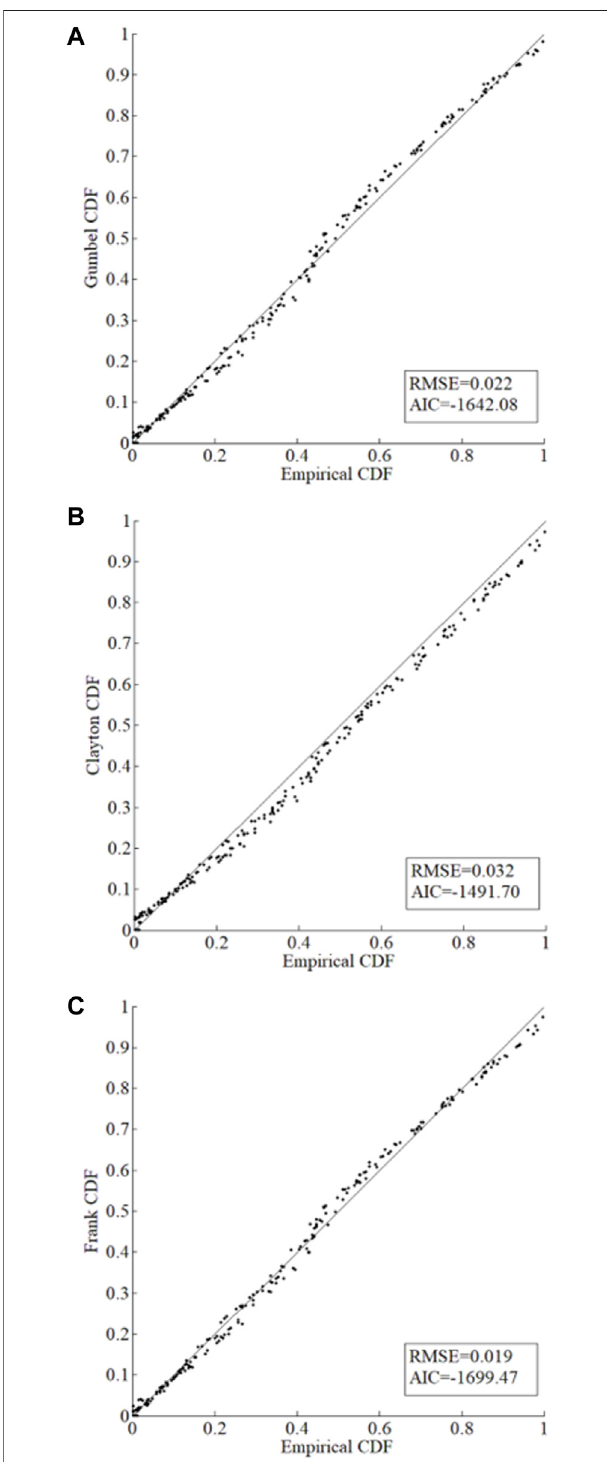
FIGURE 7 | Comparison of the theotrical and empircal joint CDFs for rainfall and runoff in Xiangxi River. (A) Gumbell-Hougard-Copula-based joint distribution. (B) Frank-Copula-based joint distribution, respectively. FIGURE 8 | The joint CDFs of rainfall and